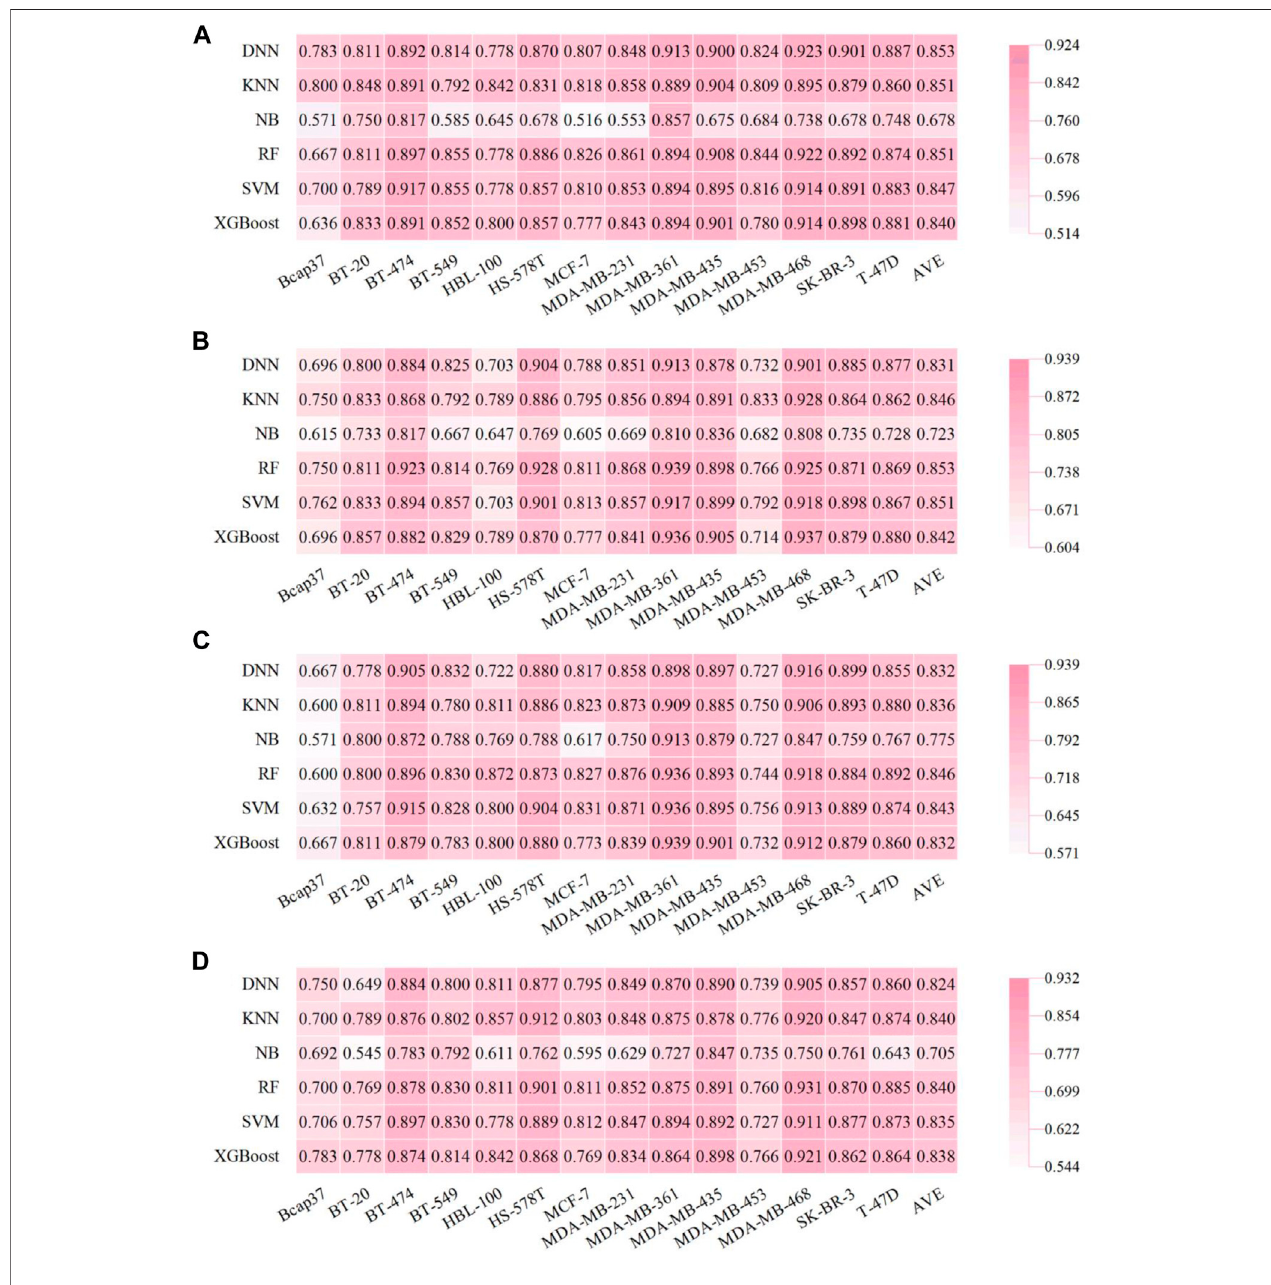
Frontiers in Pharmacology |